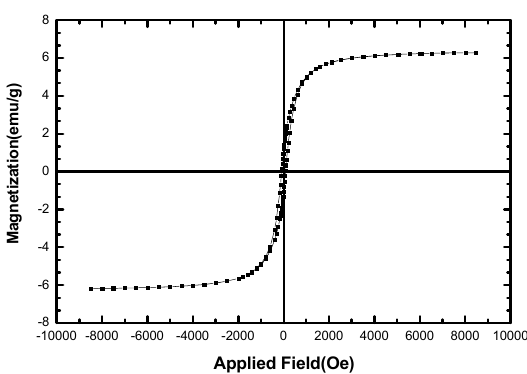
Fig. 9 . The hysteresis loop for starch/CuFe